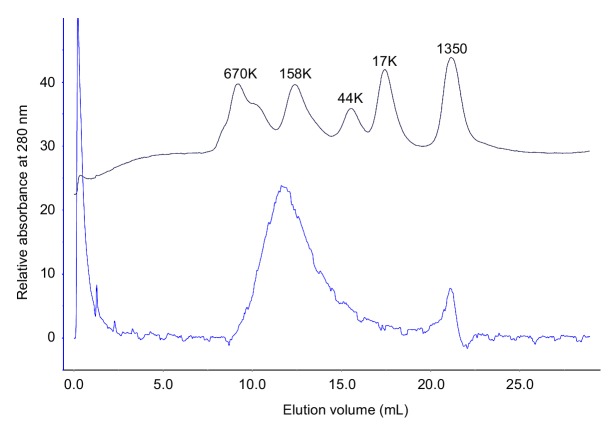
Molecular sizing of S. pombe Rad51.Rad51 was analyzed by size-exclusion chromatography. The blue and navy lines indicate the elution profiles of Rad51 and molecular weight standards, respectively.